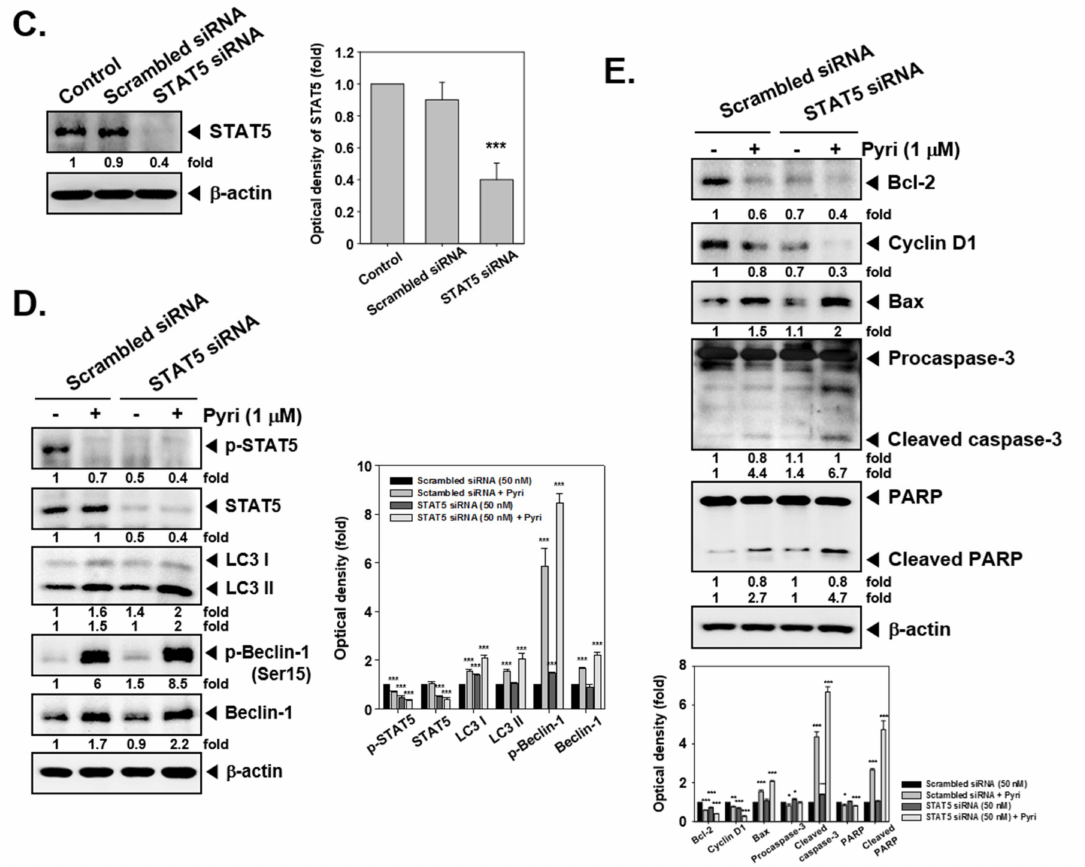
Figure 5. Inactivation of STAT5/Bcl-2 signaling can contribute to Pyri-induced cell death. ( A , B ) Pyri treatment repressed the expression of p-STAT5, p-JAK1, p-JAK2 and p-Src, as assayed by western blot. Concentrations dependent manners ( left ), time-dependent manners ( right ). ( C – E ) Western blotting was used to assess p-STAT5, STAT5 targets (Bcl-2 and cyclin D1), apoptosis-related proteins, and autophagy-related proteins in STAT5 siRNA or scrambled siRNA-transfected KBM5 cells treated with Pyri. *** p < 0.001 vs. non-treated (NT) cells, ** p < 0.01 vs. non-treated (NT) cells, * p < 0.05 vs. non-treated (NT) cells. The results shown are representative of three independent